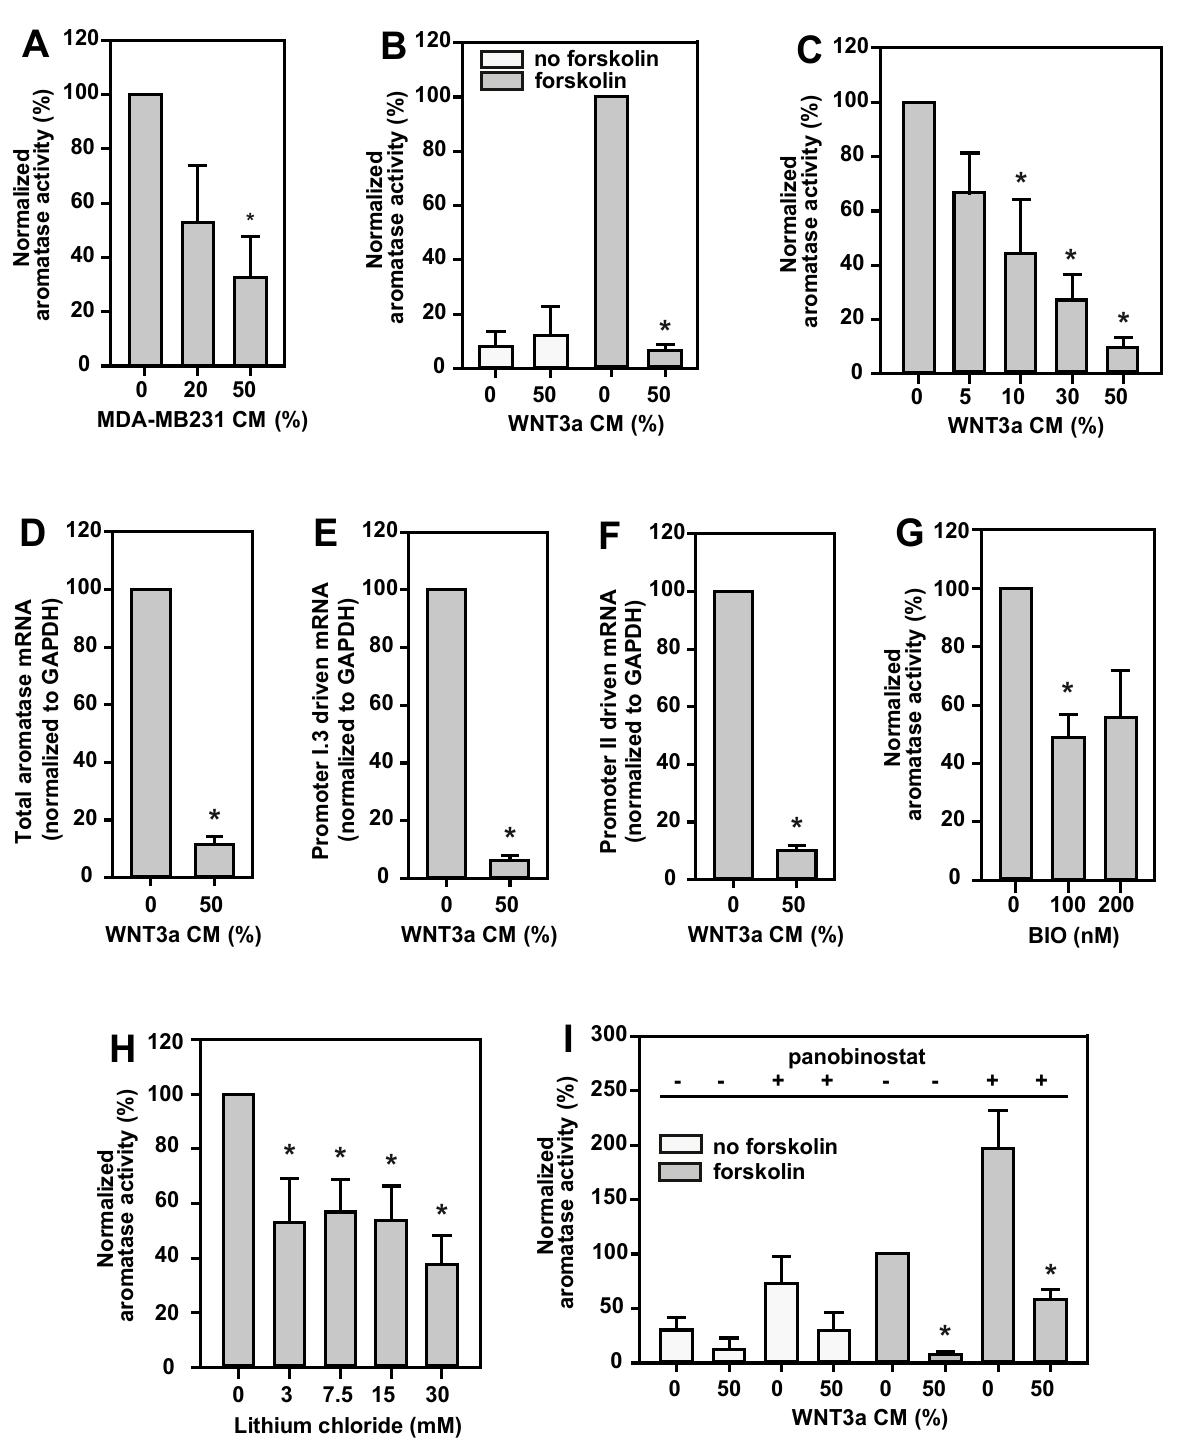
Figure 2. Aromatase in BAFs is inhibited by MDA-MB231 CM, canonical Wnt signaling, or ac- tive HDACs. BAFs were incubated for 24 h in serum-free medium supplemented with 10 µ M forskolin for aromatase induction (grey bars), or vehicle (no forskolin, white bars). Different volume percentages of MDA-MB231 CM, WNT3a CM, or different concentrations of glycogen synthase kinase-3 β (GSK-3 β ) inhibitors (BIO, lithium chloride), or the histone deacetylase (HDAC) inhibitor panobinostat (50 nM) were applied throughout the incubation time, as indicated. For measurement of aromatase activity, 3 H-labeled androstenedione was added 6 h before termination of the incubation time. Cell lysates for mRNA analyses were prepared after 24 h of treatment with forskolin, in the absence or presence of 50% ( v / v ) WNT3a CM. ( A ) MDA-MB231 CM inhibited aromatase activity